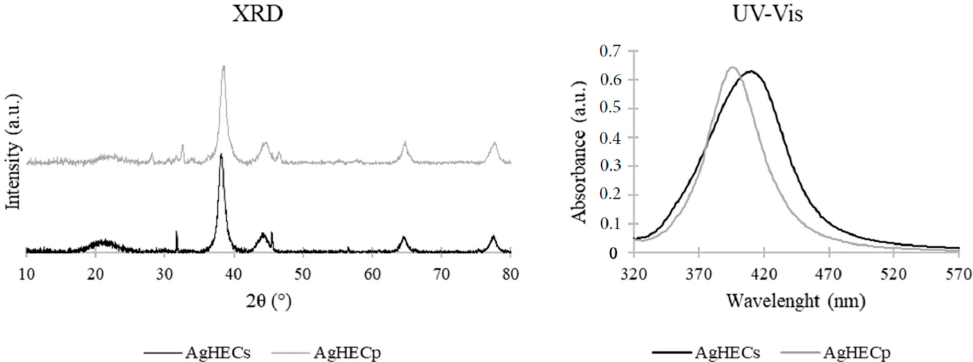
Figure 2. X-ray diffraction and UV–Vis spectra of novel NPs. XRD peaks typical of Ag NPs are re- ported together with other minor peaks related to the synthesis process. The UV–Vis absorption spectra agree with the silver core nature of the novel